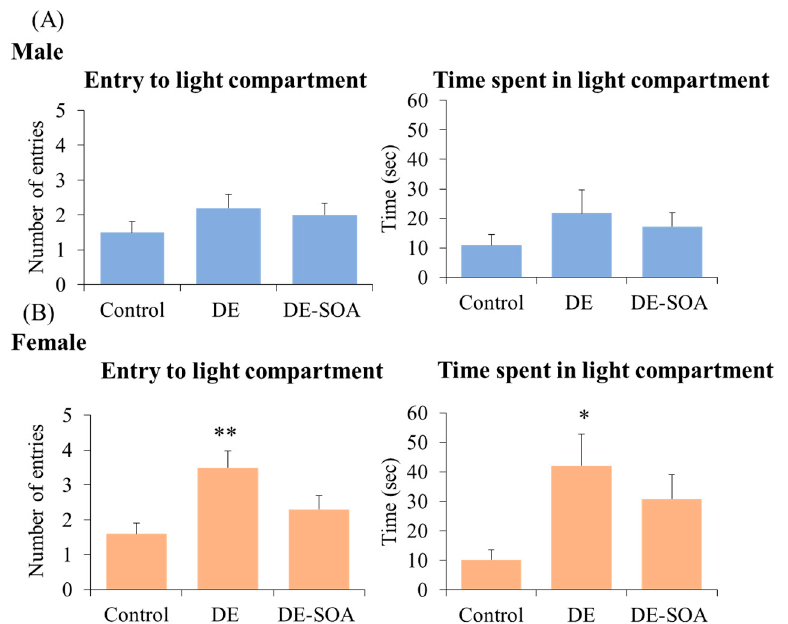
Figure 4. Light dark transition test. Number of entries and time spent in the light compartment in 10-week-old ( A ) male and ( B ) female rats of the control and the DE- or DE-SOA-exposed groups ( n = 10, ** p < 0.01, * p < 0.05 vs. corresponding control).